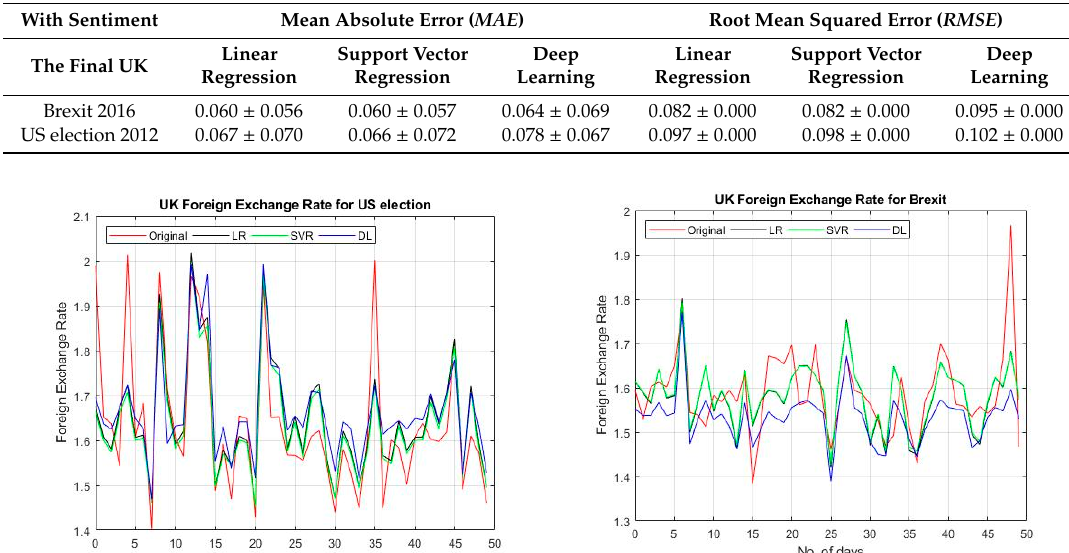
Figure 6. The plot of 50 forecasted and actual values of the foreign exchange rate of the UK considering linear, support vector, and deep learning model with the sentiment of US election and Brexit. LR: Linear regression, SVR: Support vector regression, DL: Deep learning.